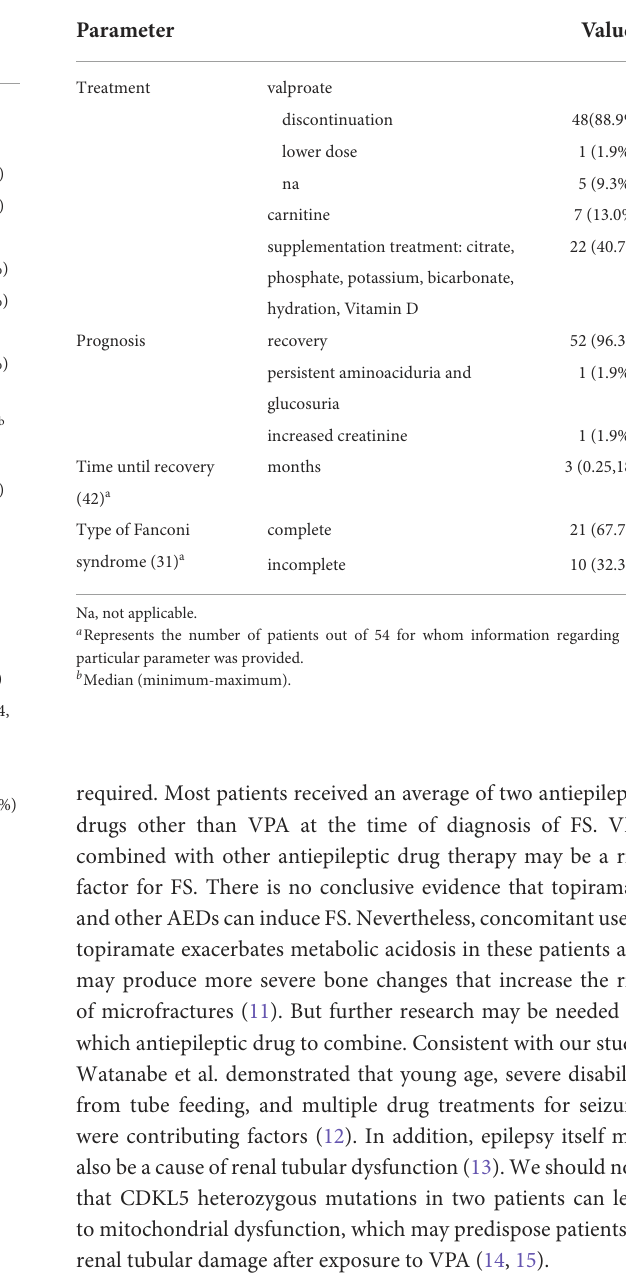
TABLE 5 Treatment and prognosis of the 54 included